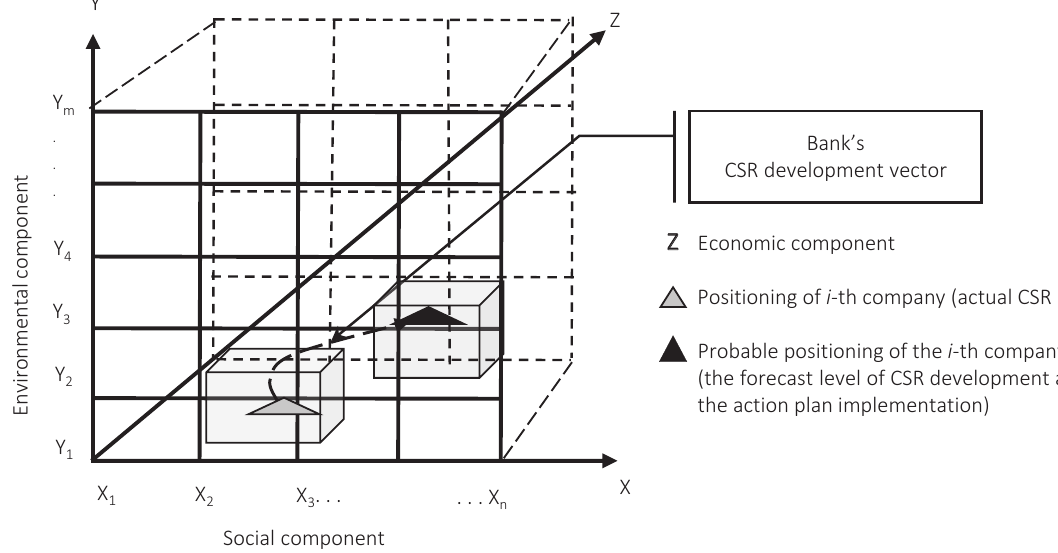
Figure 2. The three-dimensional positioning matrix of bank’s corporate social